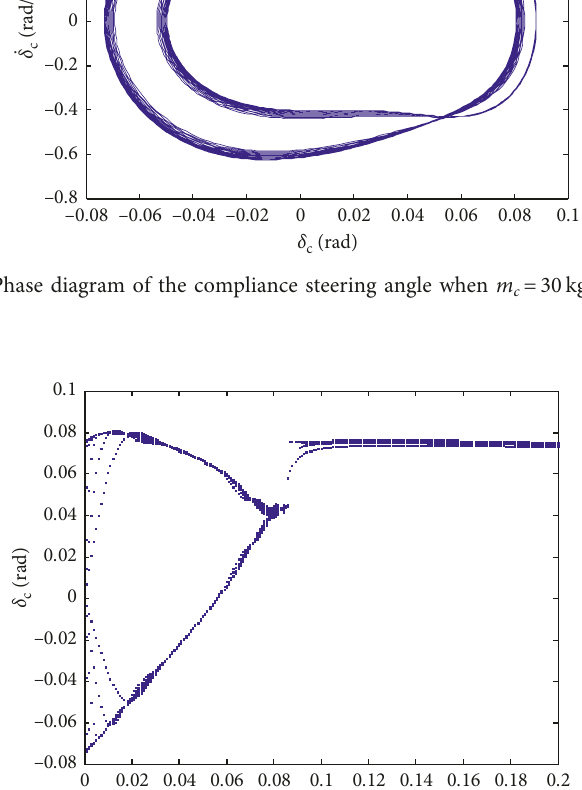
0.2, m c 100kg and (b) c (cid:30) (cid:30)